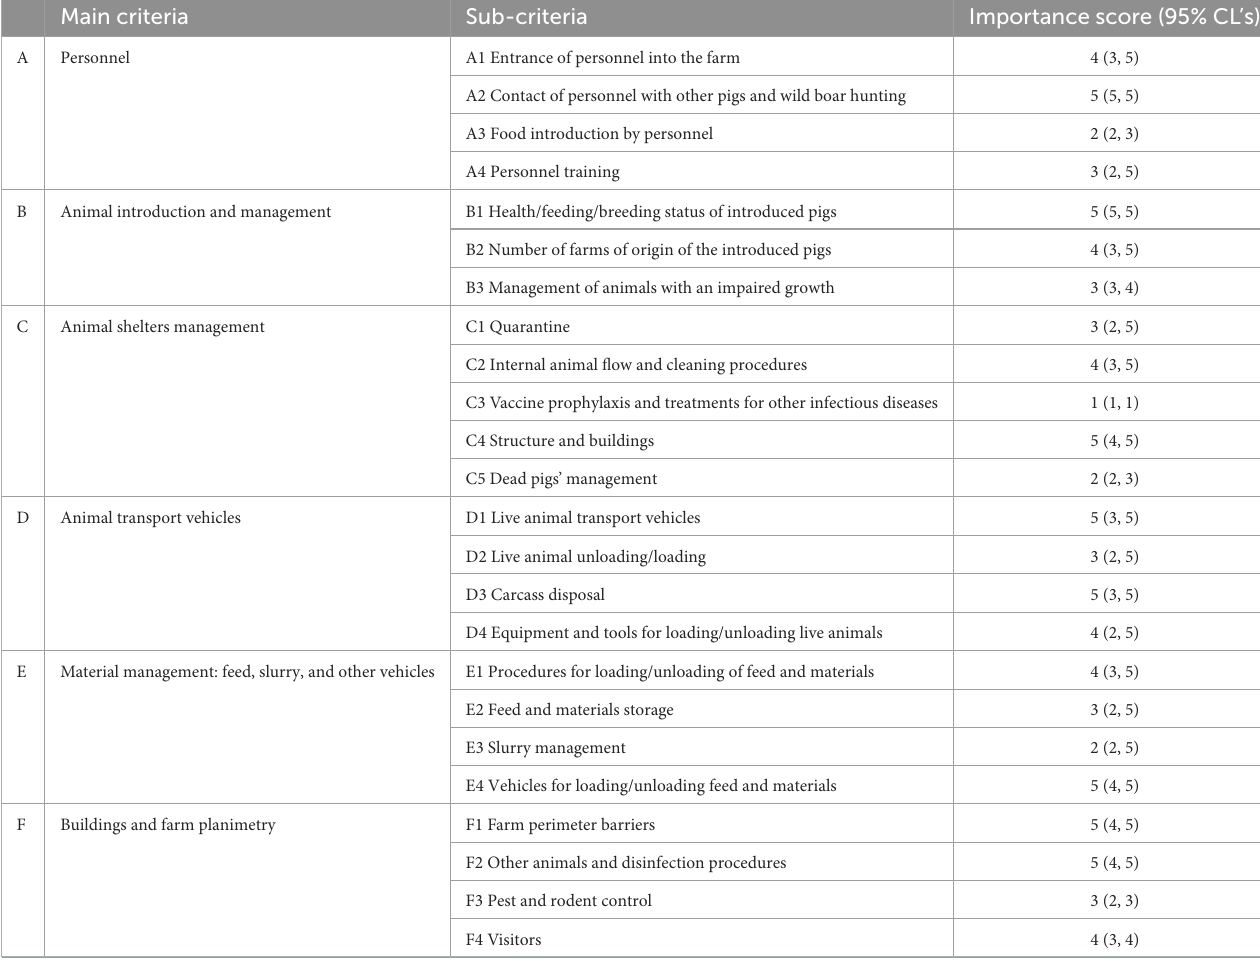
TABLE 1 Main criteria and sub-criteria of the ASF specific checklist and the importance score of each sub-criterion assigned by the experts’ opinion. Main